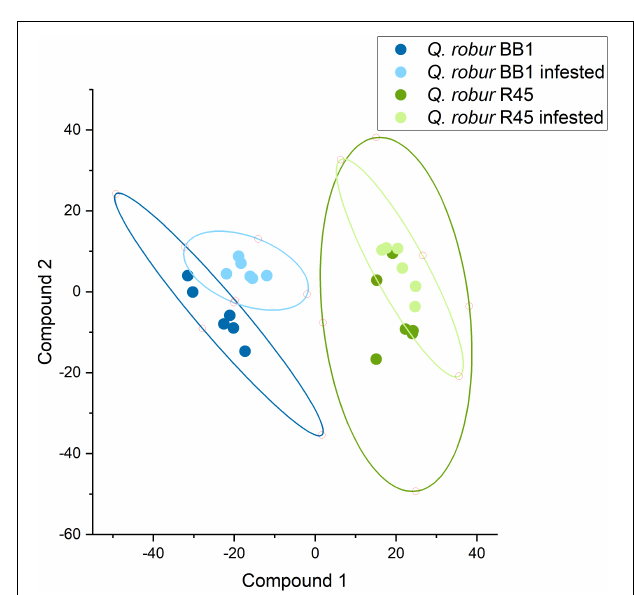
FIGURE 6 | PLS-DA of root-released VOC patterns of two different Q. robur populations ( N = 6). Six trees of each population were infested for 7 days by two cockchafer grubs each. Volatiles in the soil were trapped by passive samplers which were placed in the soil during the course of the experiment. Ellipses reflect the 95% confidence